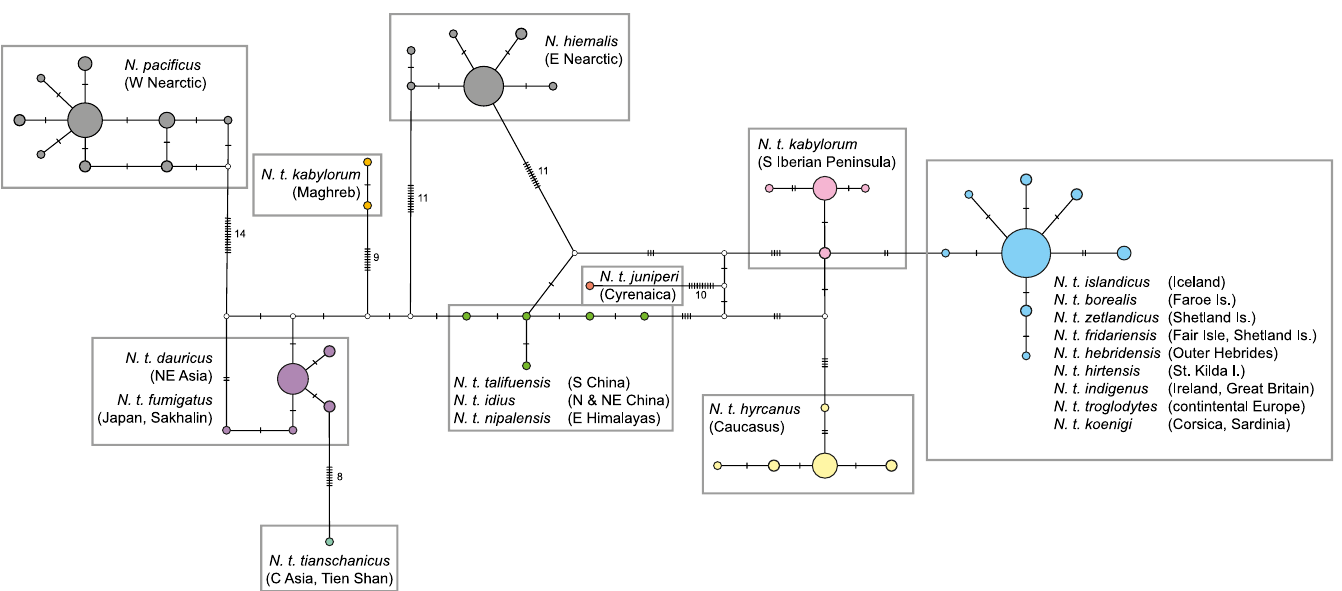
Fig 3. TCS haplotype network drawn for the mitochondrial ND2 of the Nannus pacificus/hiemalis/troglodytes species complex including 18 subspecies of N . troglodytes . Haplotype circles scaled to sample size (n) of each represented haplotype (total sampling: n = 174); substitution distances not to scale.